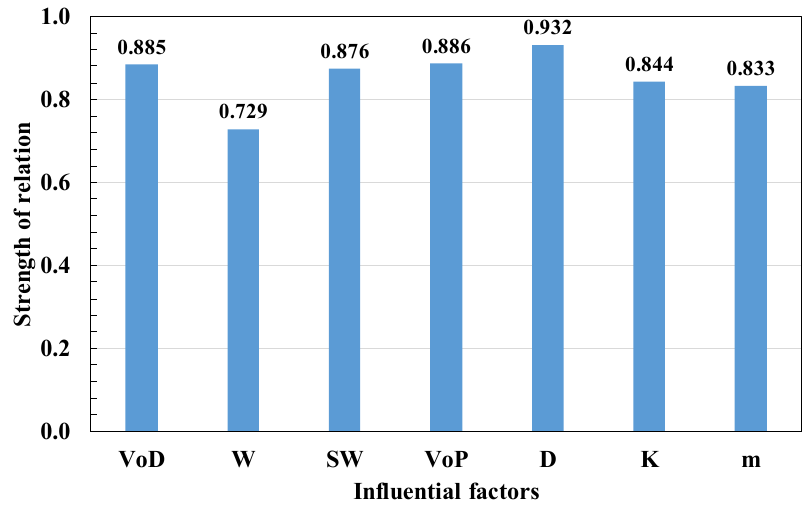
Figure 7. Sensitivity analysis of the influential factors.